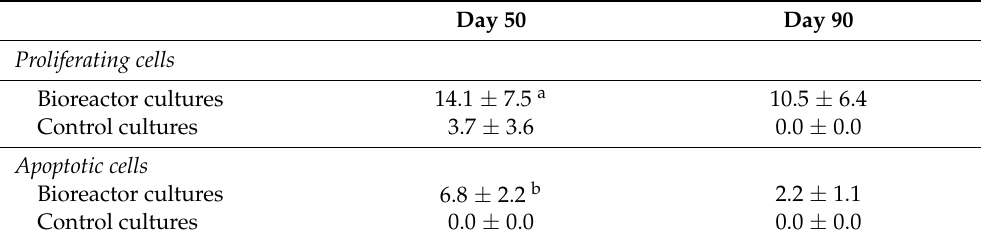
Table 3. Densities of proliferating and apoptotic cells according to the culture type and time.